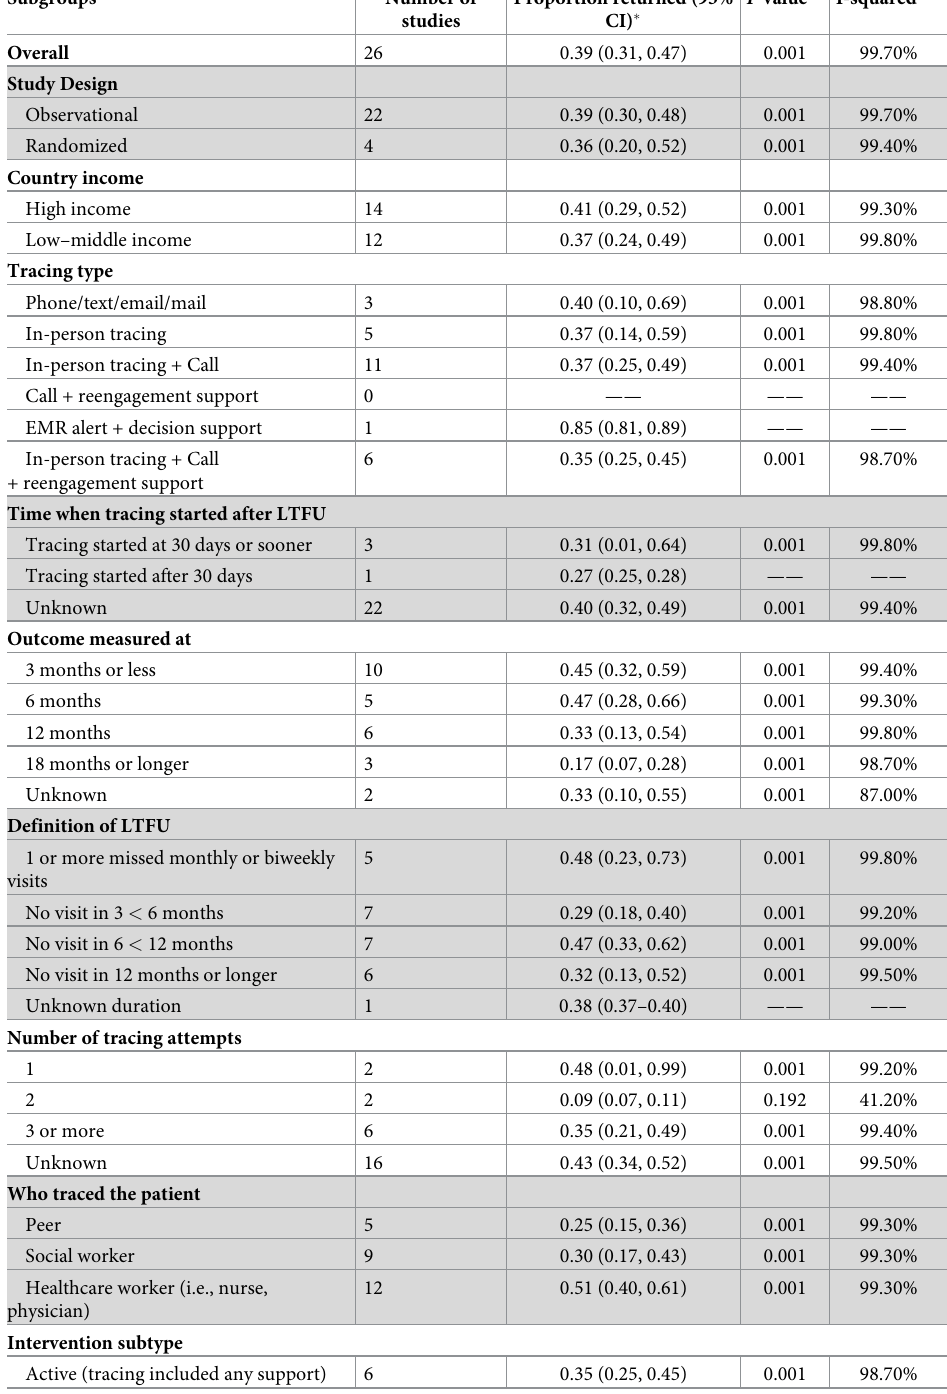
Table 6. Reengagement program outcome: Proportion of all patients who were LTFU returned to the clinic by